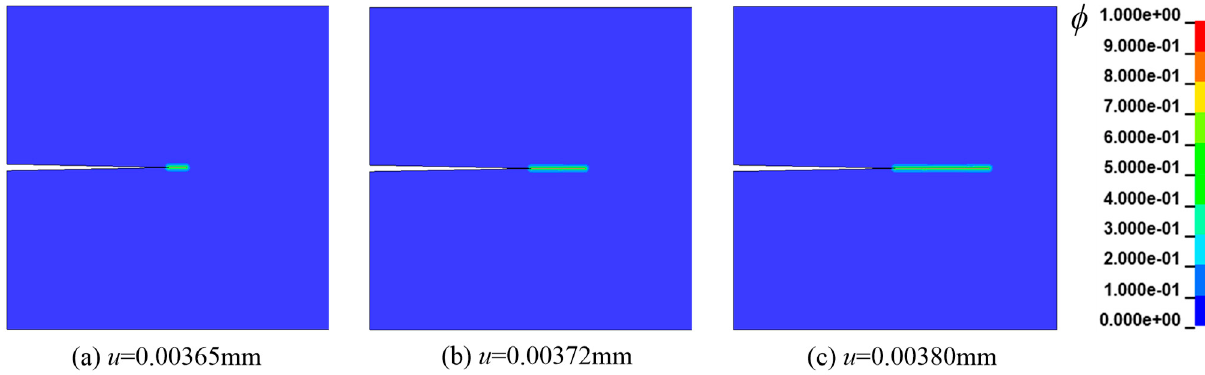
Figure 7. Crack growth process in Case 1 ( C 0 = 0.5 wt ppm).